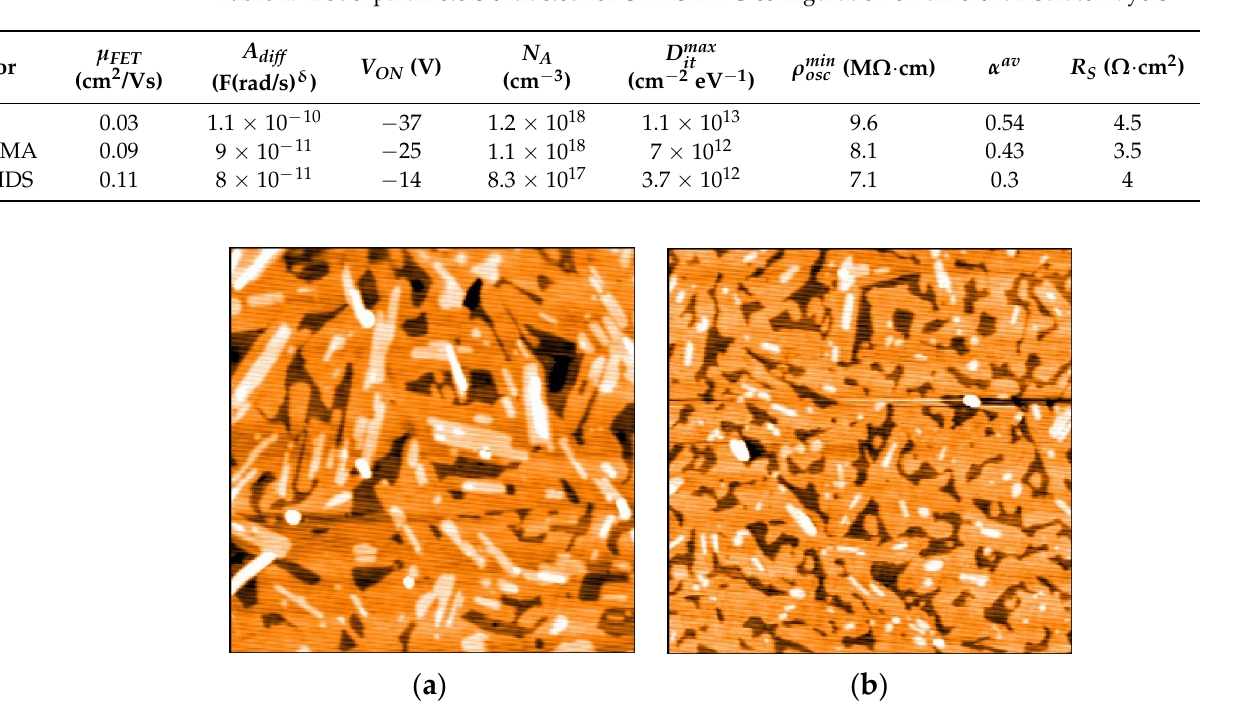
The admittance curves of the devices with semiconductors deposited on HMDS at higher temperatures are reported in Figure 6. The parameters extracted through the model (Table 2) show that the main effect of the increase in substrate temperature during deposition was improvement of the OSC conductivity, with a reduction in both the interface traps and bulk dispersion, while an excessive increase in temperature led to a deterioration in performance. Table 1. Model parameters extracted for OTFTs in BG configuration on different insulator layers.